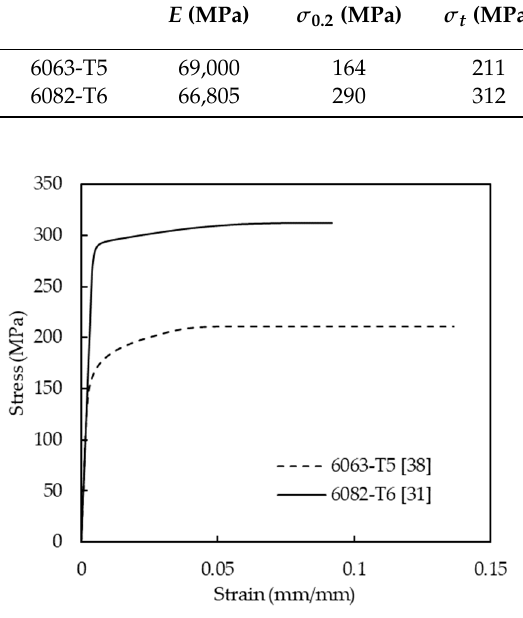
Table 4. Material properties of 6063-T5 [38] and 6082-T6 [31] aluminium alloys adopted in parametric study.